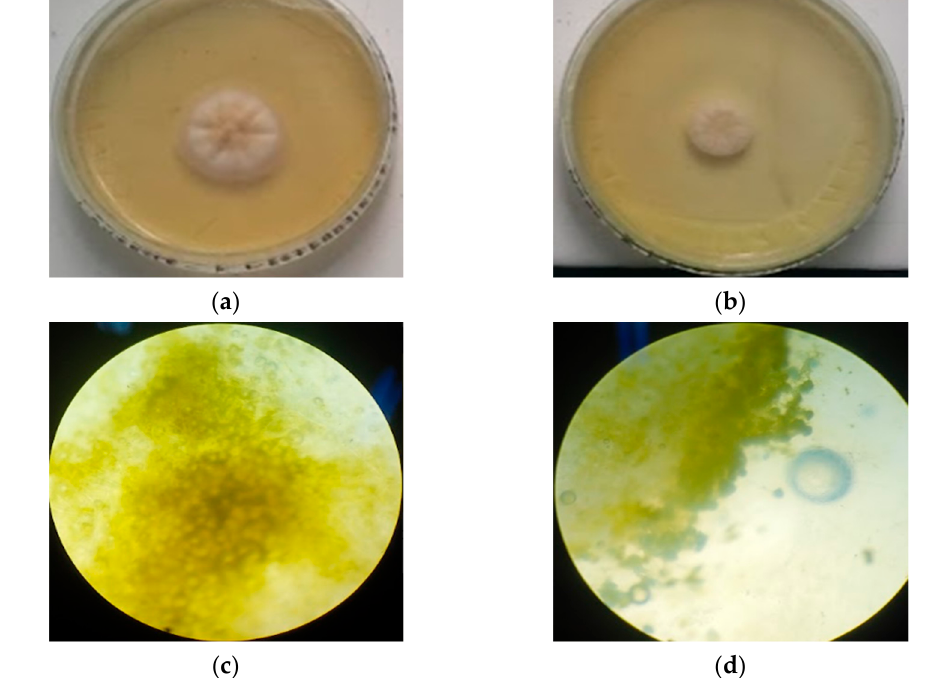
Figure 8. Macroscopic and microscopic comparison between the colonies with or without the NE at 2048 µg/mL at 48 h: ( a ) A. westerdjikiae colony, ( b ) A. westerdjikiae colony in the presence of the NE at 2048 µg/mL, ( c ) microscopy of A. westerdjikiae , and ( d ) microscopy of A. westerdjikiae in the presence of the NE at 2048 µg/mL.